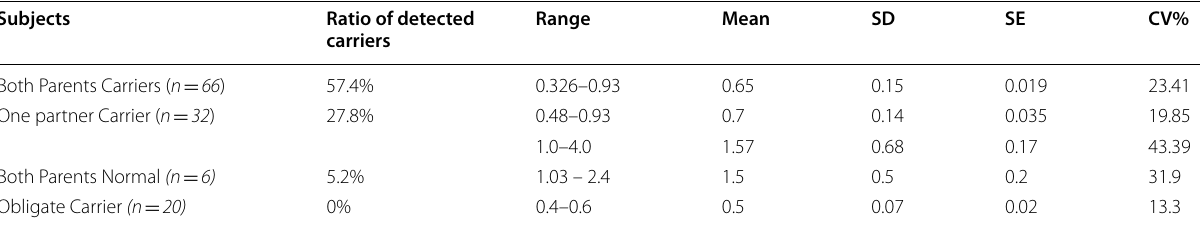
106) and 10 obligate carries couples ( n =